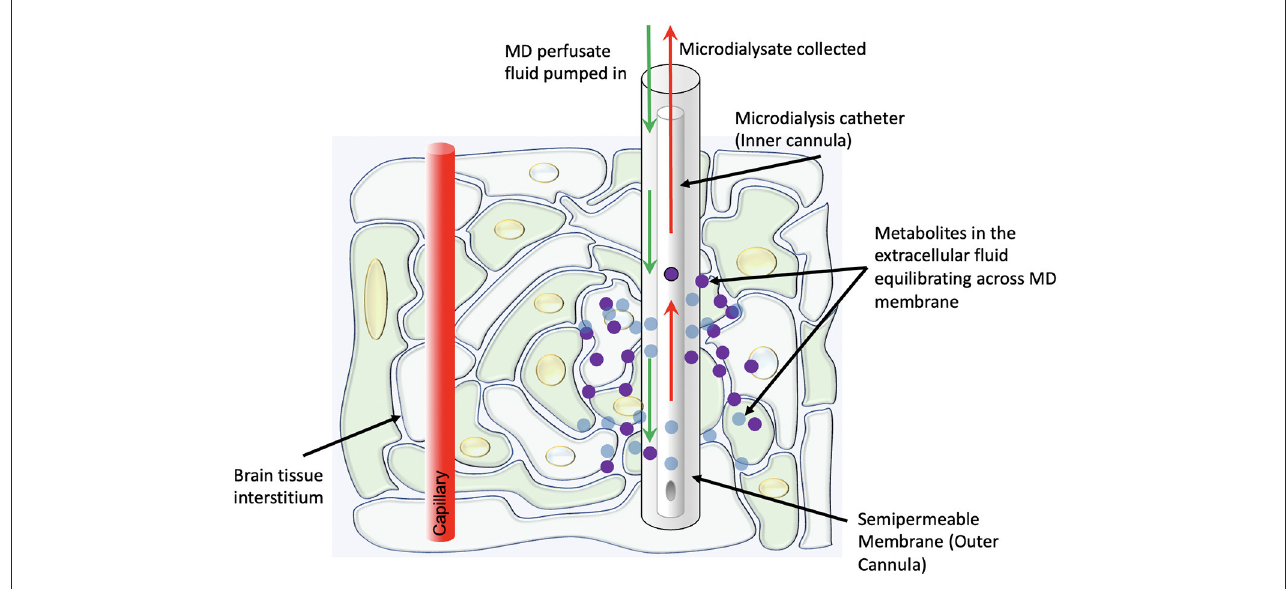
FIGURE1 Schematic representation of the physiologic concept behind cerebral